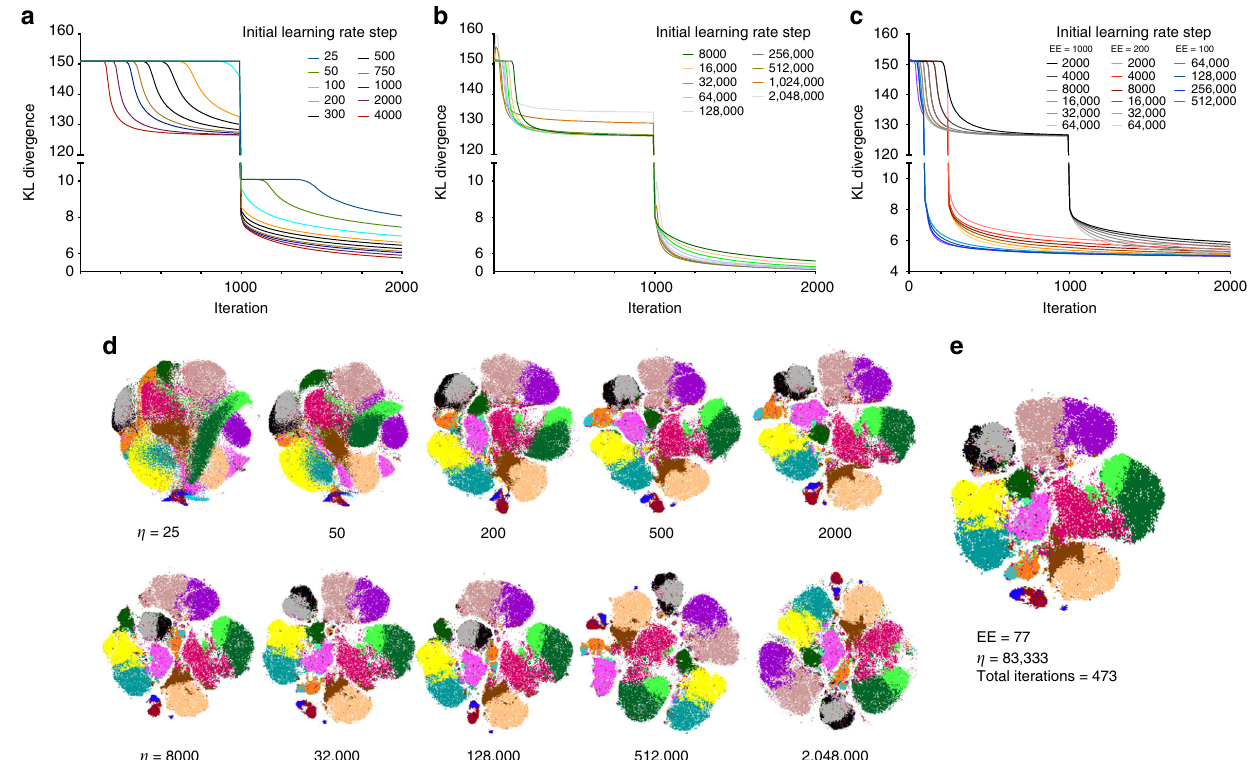
Fig. 4 Learning step size optimization for t-SNE visualization of large datasets. a – c KLD change over iterations for embeddings with varying values of initial learning rate step size, color coded as indicated. a EE = 1000 iterations, learning rate step = 25 – 4000; b EE = 1000 iterations, learning rate step = 8000 – 2,048,000; c EE = 100 – 1000 iterations, learning rate step = 2000 – 512,000. d Representative t-SNE plots of embeddings graphed on a . e t-SNE plot of an optimized embedding. All color overlays on t-SNE plots correspond to cell type classes labeled as in Figs. 1, 2. Representative examples of multiple runs with varying seed values are shown